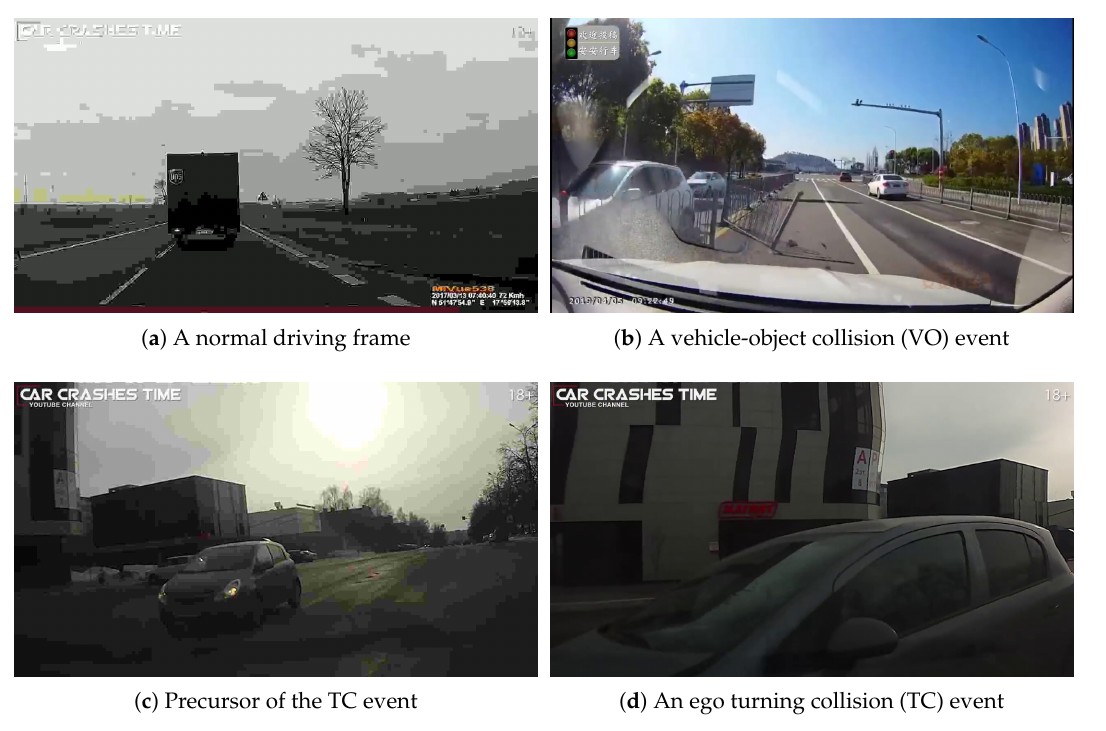
Figure 2. Compressed normal frames ( left ) and preserved anomalies ( right